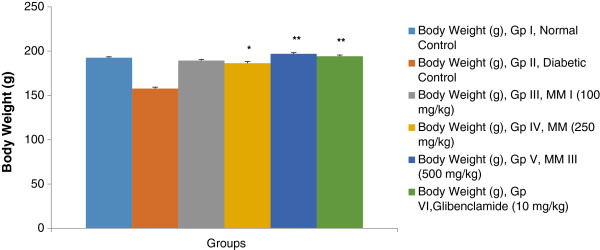
Effect of Melastoma malabathricum Linn. (MM) on body weight at different concentrations on STZ induced diabetic rats, compared to standard drug Glibenclamide; values are mean ± SEM; n = 6; *P < 0.05; **P < 0.01; ***P < 0.001; P > 0.05 is considered as non-significant (ns).